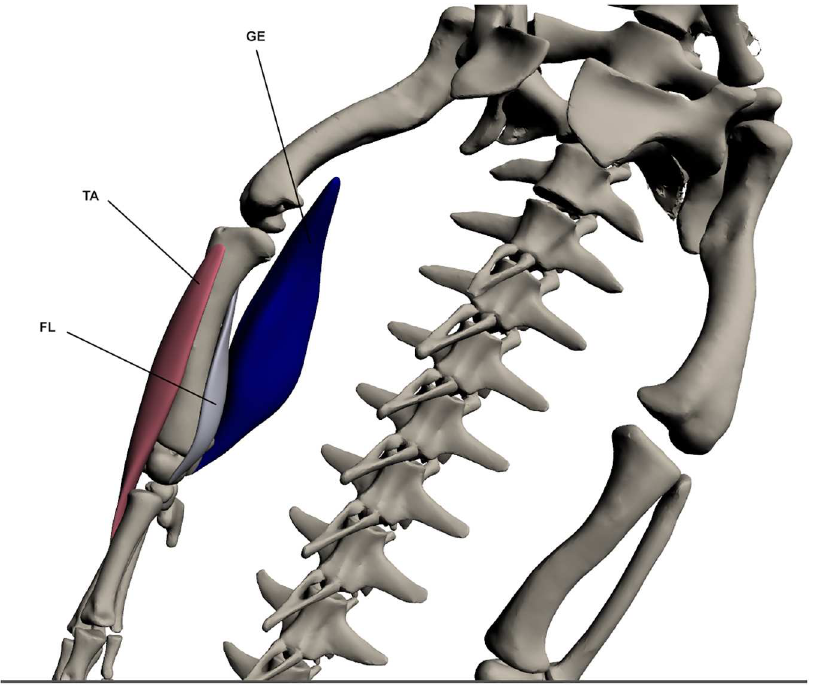
Fig 17. Superficial dorsal muscles of the lower hindlimb. GE: Gastrocnemius externus , TA: Tibialis anterior ,FL: Fibularis longus